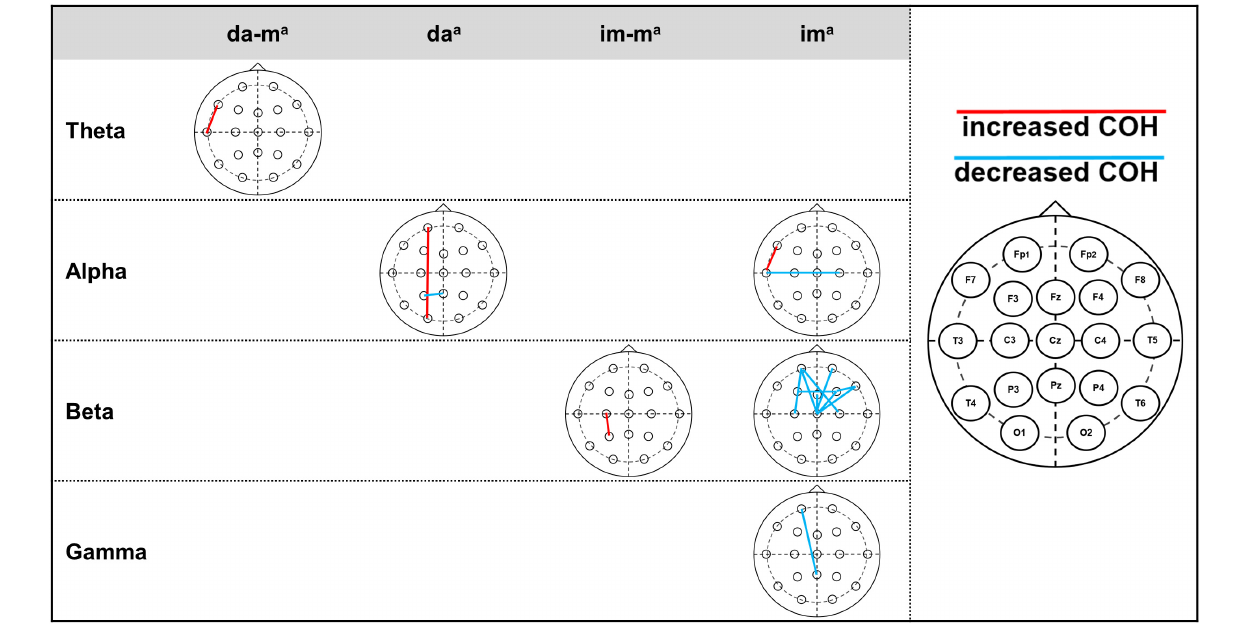
FIGURE 2 | Significant time effects for jointly electrode pairs of COH and ICOH. Statistically significant time effects of the jointly electrode pairs of COH and ICOH with presentation of the increased or decreased COH. Right column: head model of 10–20 system, electrode pairs with increased COH presented by red lines, electrode pairs with decreased COH presented by blue lines. a da-m, physically executed dance with music; da, physically executed dance without music; im-m, imagined dance with music; im, imagined dance without